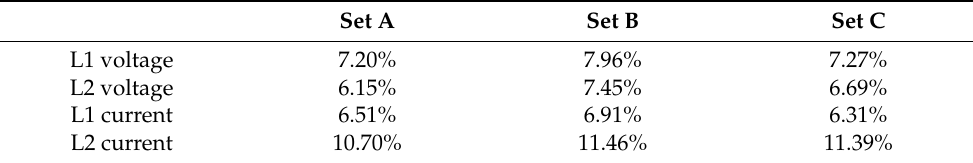
Table 6. THD of output voltages and currents of the inverter—1 s window. Set A Set